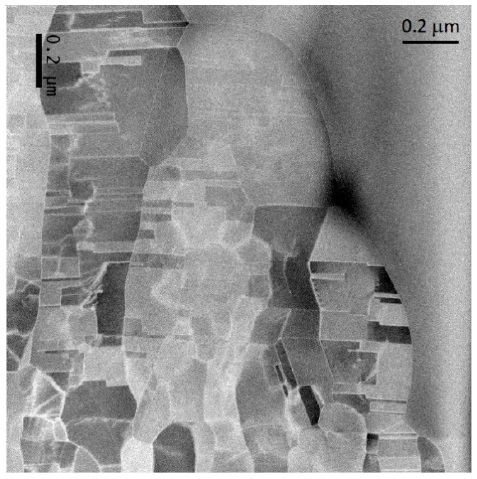
Figure 3. Scanning transmission electron microscope (STEM) image of twinned structure. Twins spacing is measured to be approx. 30–40 nm wide.